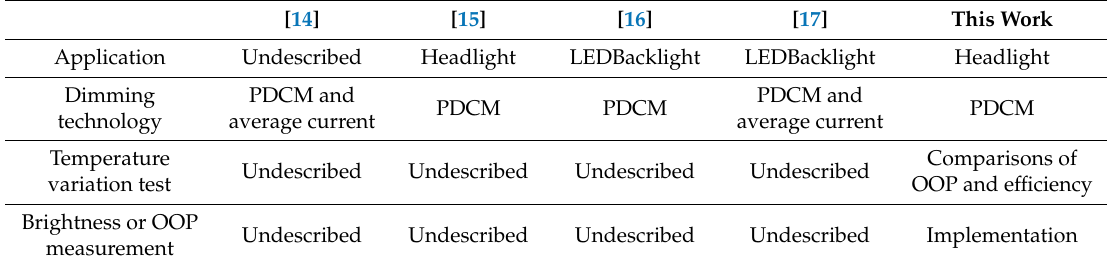
Table 2. Dimming technology comparisons of average current modulation and pulse-duty-cycle modulation